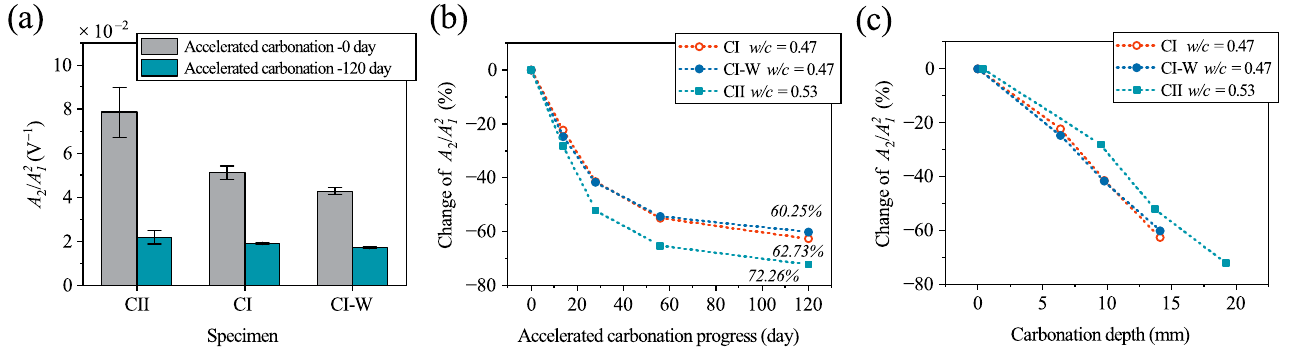
Figure 11. Variation ratio of nonlinearity parameters of CI, CII, and CI-W.